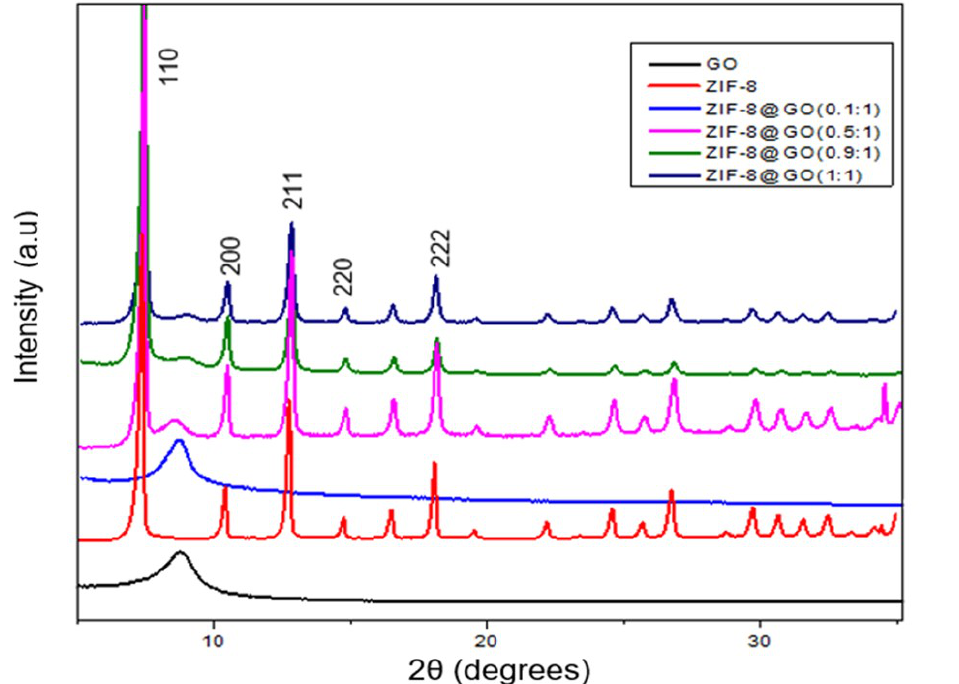
Figure 4. XRD spectra of GO, ZIF-8 and ZIF-8@GO composites showing their evolution with increas- ing ZIF-8 content in the